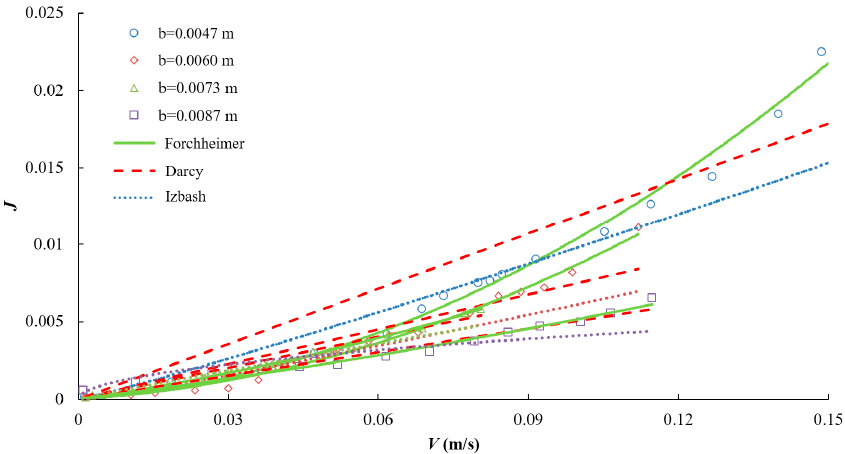
Figure 8. The V – J relationship and fitting results for flow through single fractures with trapezoidal roughness. Table 3. Fitting results and goodness of fit for the V – J relationship for flow through single fractures with smooth parallel plates.